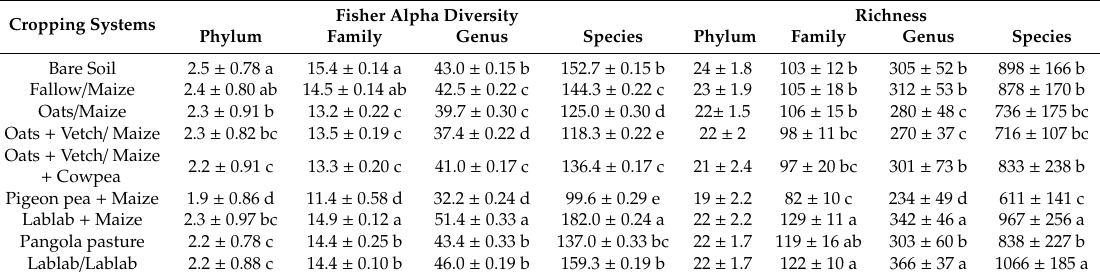
Table 3. Fisher alpha diversity and richness for nine planting treatments. All unclassified sequences were clustered and considered in the diversity analysis. Means that di ff er significantly indicated